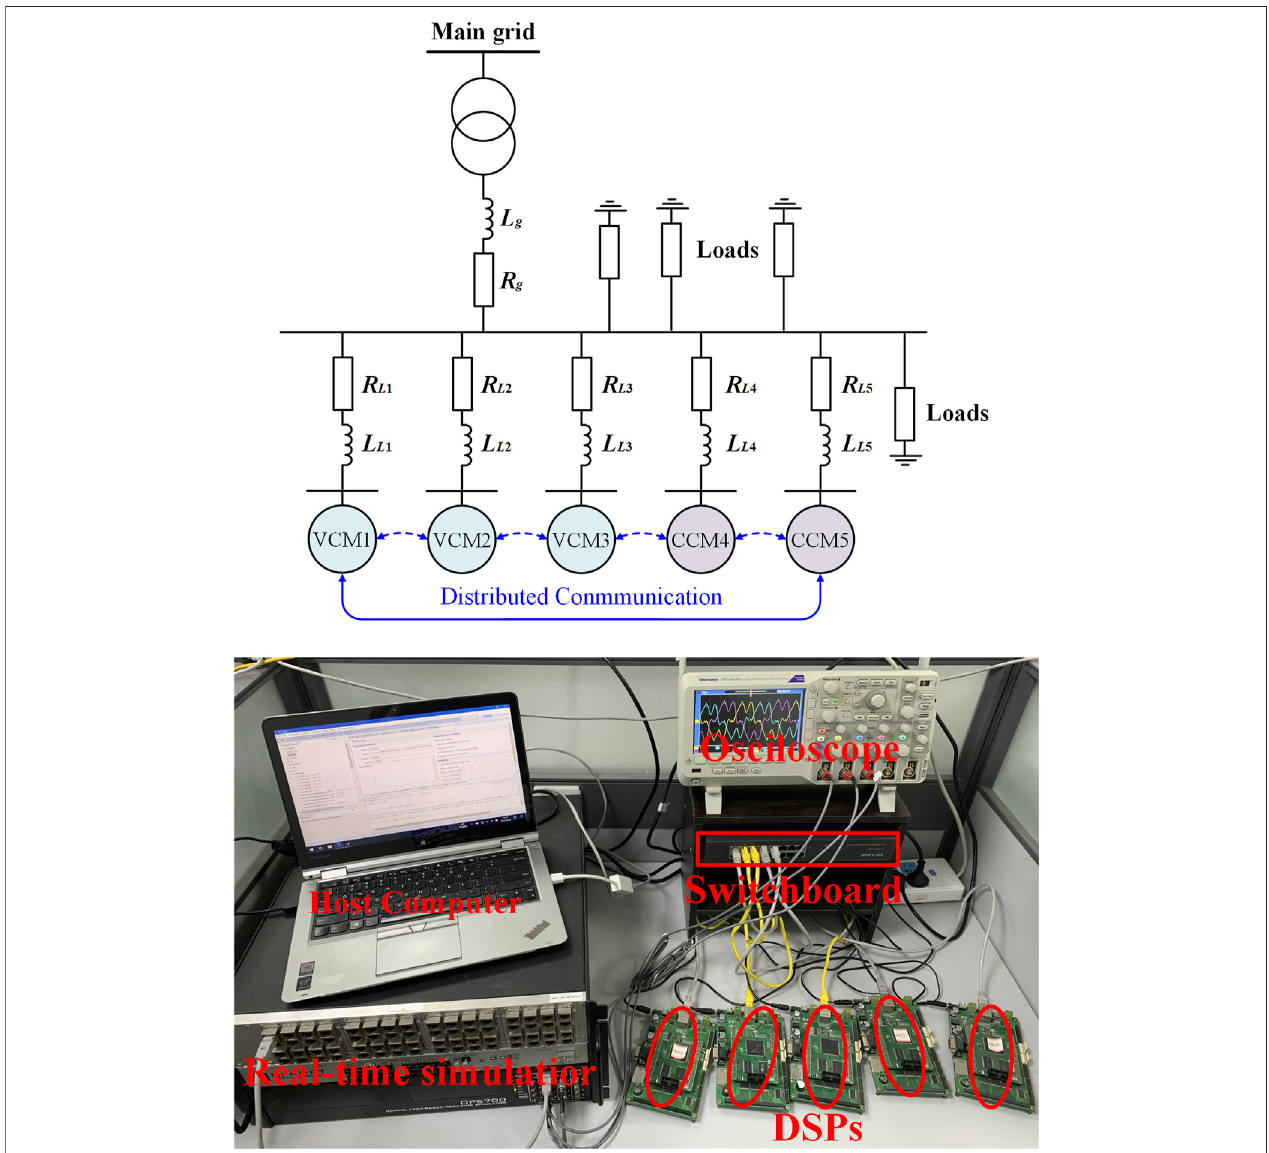
FIGURE 10 | Structure diagram and controller hardware-in-the-loop platform of the simulation distribution network.